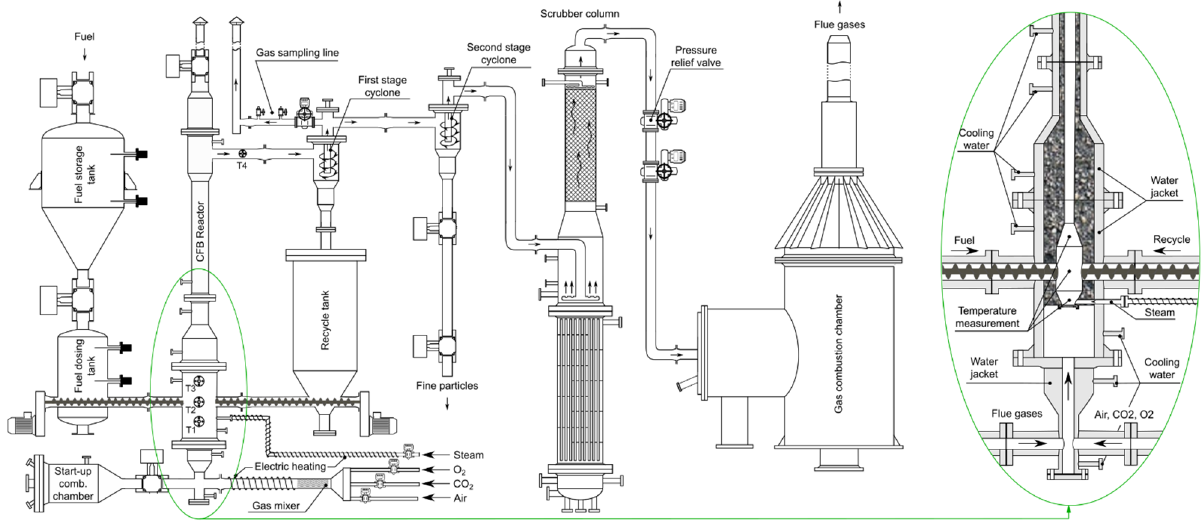
Figure 2. Schematic representation of the CFB installation.